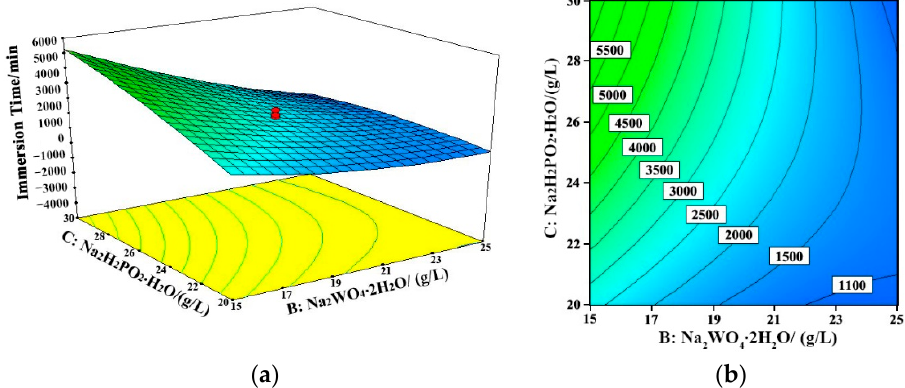
Figure 5. Response surface ( a ) and contour map ( b ) of the coating failure time with the change of nickel sulfate and sodium tungstate concentrations (sodium hypophosphite concentration = 25 g/L, 60 °C, pH = 8.7). A : NiSO 4 ·6H 2 O; B : Na 2 WO 4 ·2H 2 O.